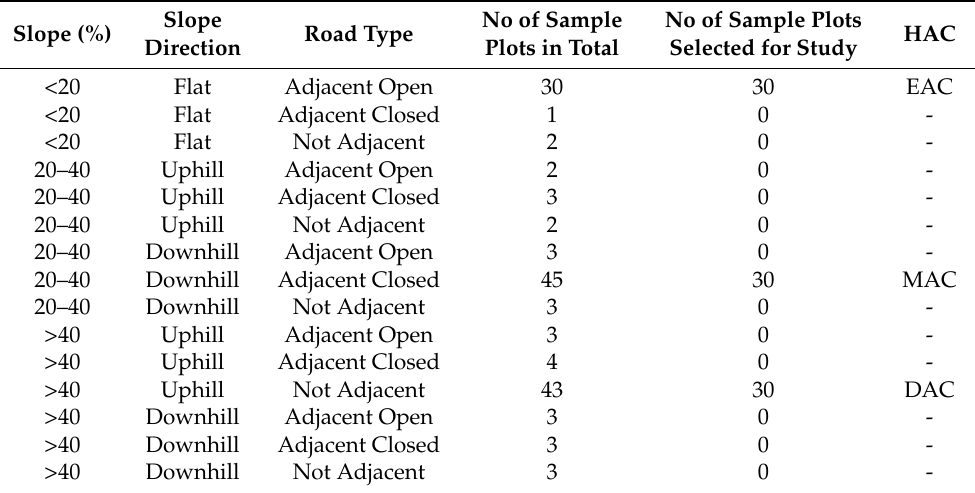
Table 1. Classification of the sample plots on the base of slope degree, slope direction and road type. Slope